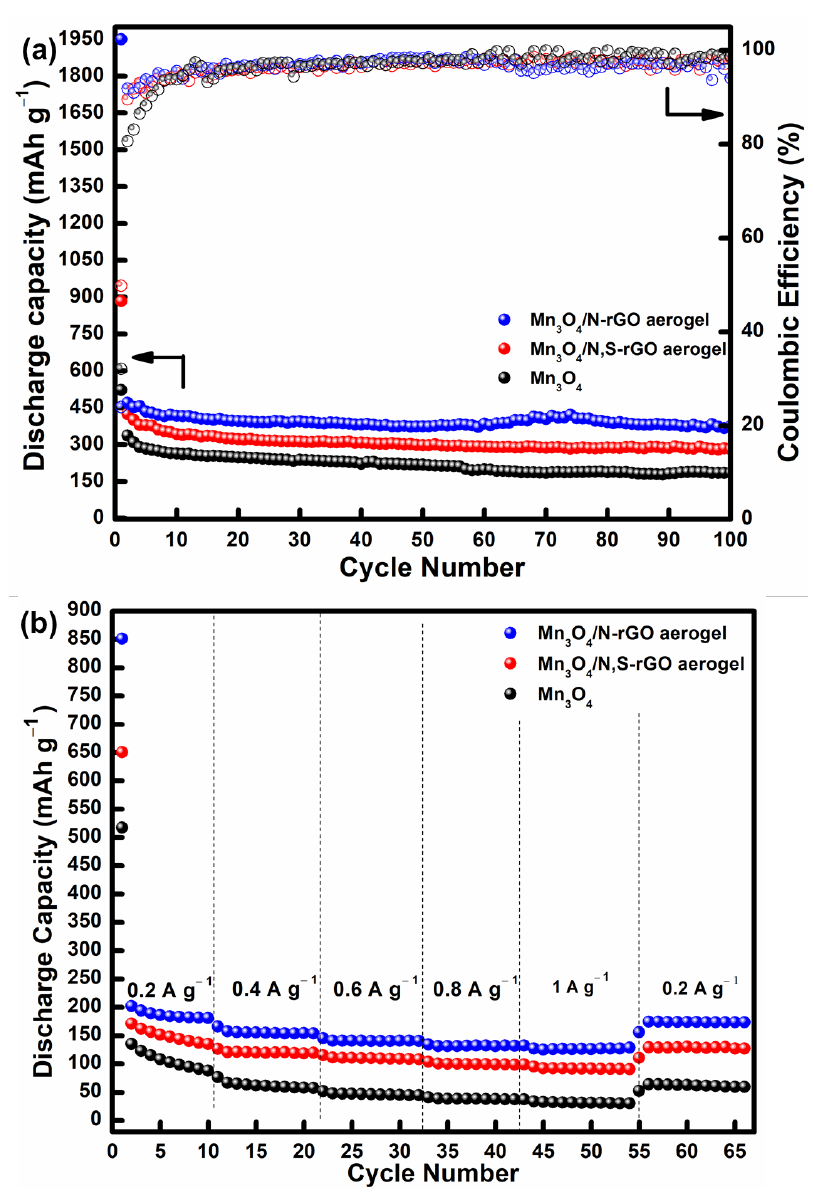
Figure 10. ( a ) Cycling performances and Coulombic efficiencies of up to 100 cycles at a current density of 0.1 A g −1 and ( b ) rate capability at different current densities for Mn 3 O 4 , Mn 3 O 4 /N-rGO aerogel, and Mn 3 O 4 /N,S-rGO aerogel.